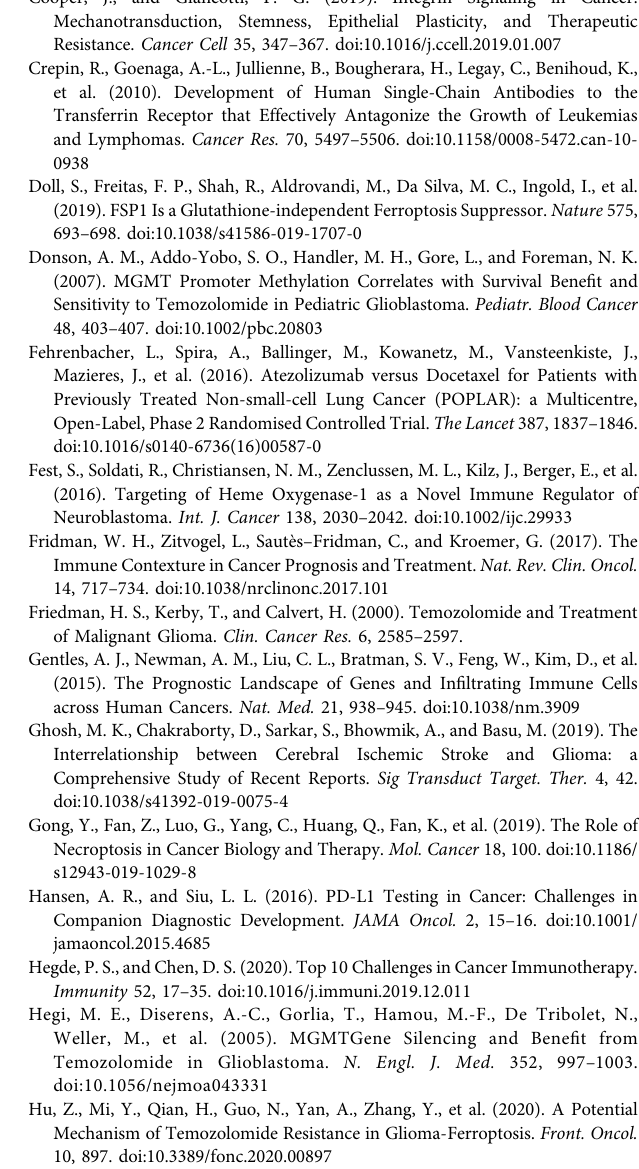
Supplementary Table 1 | The baseline clinical characteristics of glioma patients. Supplementary Table 2 | 24 ferroptosis-related genes for consensus clustering. Supplementary Table 3 | 173 ferroptosis-related genes list. Supplementary Table 4 | 1793 immune-related genes list. Supplementary Table 5 | 94 ferroptosis suppressors list. Supplementary Table 6 | 2183 DEGs list between C1 and C2. Supplementary Table 7 | 2189 DEGs list between G1 and G2. Supplementary Table 8 | 2613 genes list in blue module. Supplementary Table 9 | 263 DEGs between the high and low FRGPI groups. Supplementary Table 10 | Function enrichment analysis results for 263